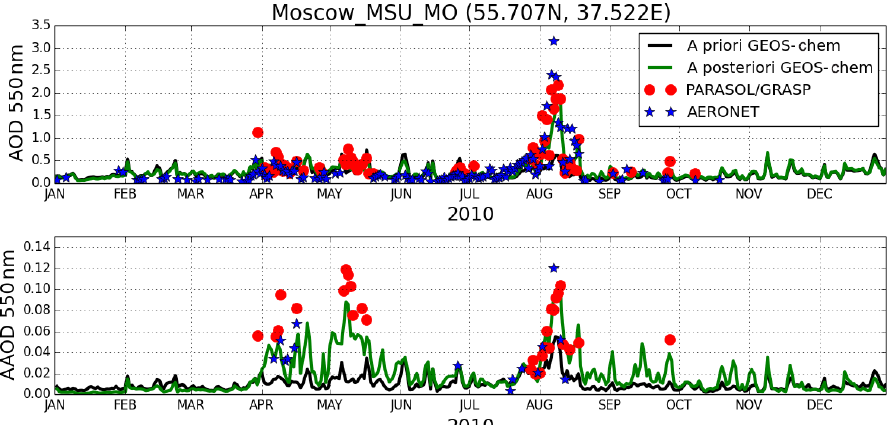
Figure 8. Time serial plot of AOD and AAOD at 550nm from AERONET (blue star), PARASOL/GRASP (red circles), a priori (black line) and a posteriori (green line) GEOS-Chem simulations at the Moscow_MSU_MO (55.707 ◦ N, 37.522 ◦ E) site.